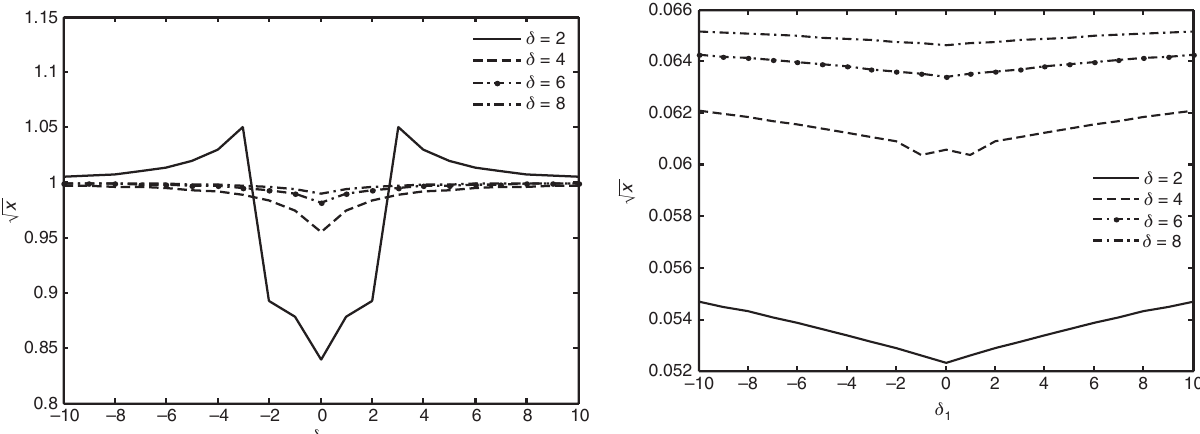
Figure 7: Variations of non-dimensional phase speed ( ) x against impedance parameter δ